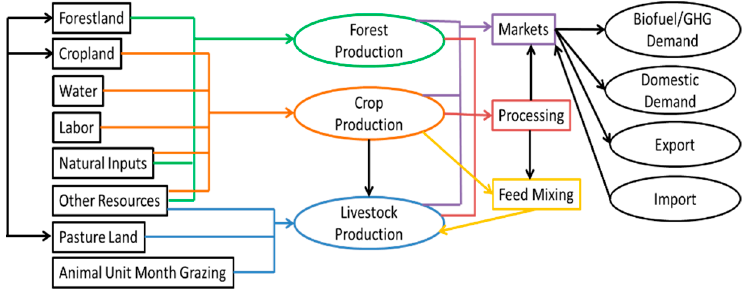
Figure 2. FASOMGHG model structure. Source: Adapted from McCarl and Sands [24].